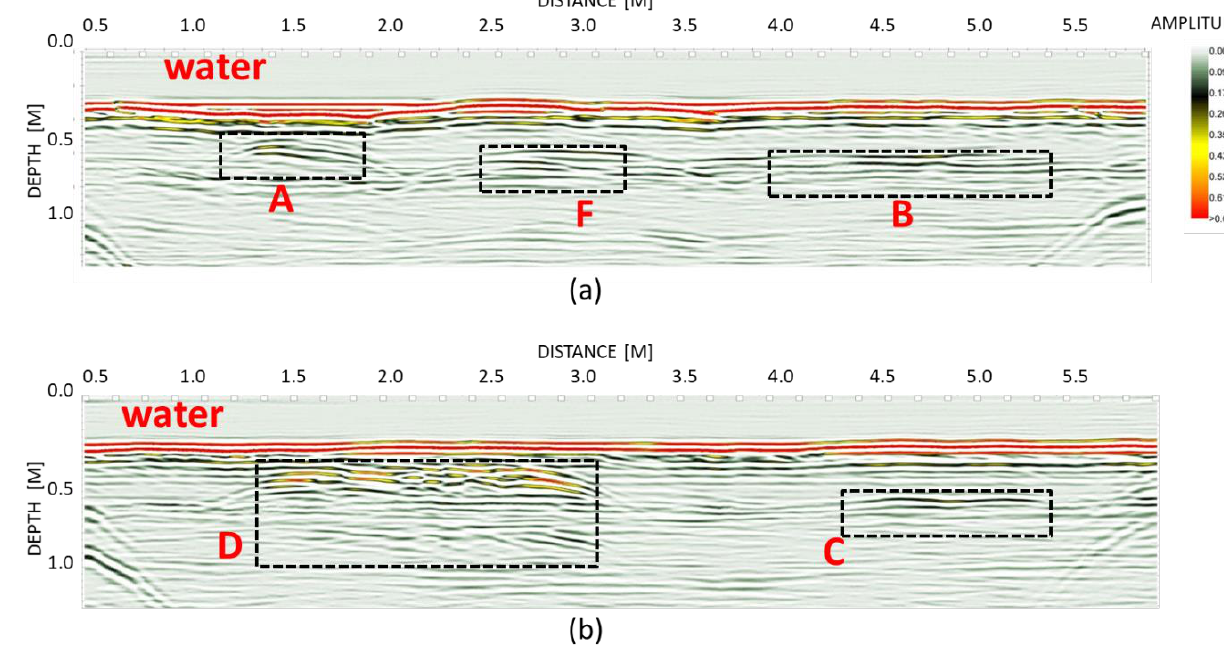
Figure 12. 3D loop – loop ERT depth-slices at 0.25 m ( a ), 0.45 m ( b ), 0.70 m ( c ), and 1.00 m ( d ) in WL1.